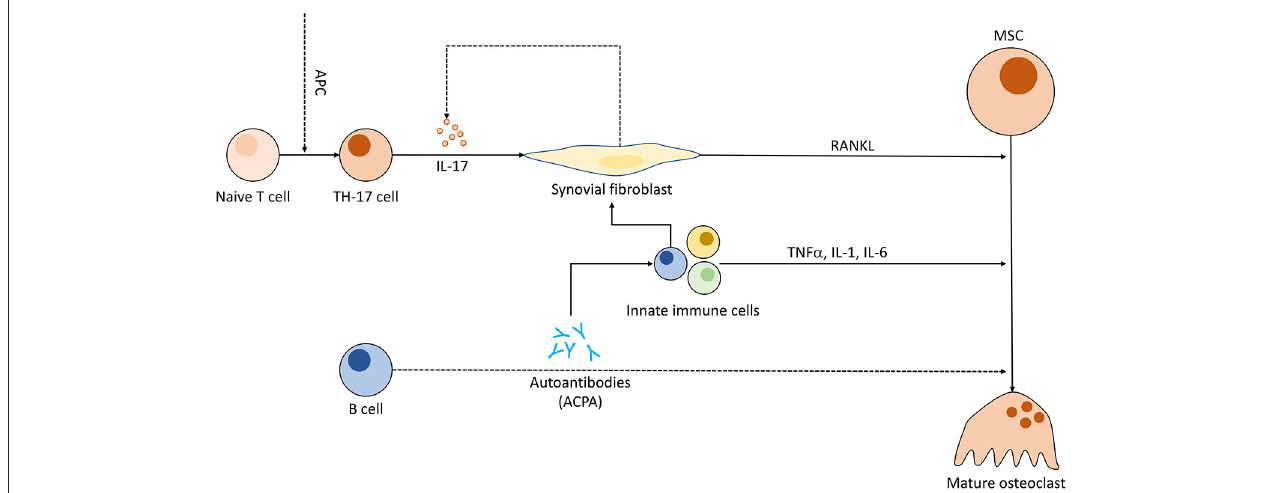
FIGURE 5 | Pathogenic role of immune cells in rheumatoid arthritis and the connection to osteoclastogenesis. Antigen-presenting cells (APC) induce T cell differentiation to Th17 subgroup. Th17 cells, when triggered, emit IL-17, compelling fibroblasts to produce RANKL and indirectly stimulate increased IL-17 production. ACPAs (anti-citrullinated peptide antibodies) synthesized by B cells might be (dotted line) capable of enhancing OC differentiation and entice other pro-inflammatory immune cells to cytokine production. These immune cells in turn prompt fibroblasts to secrete even more